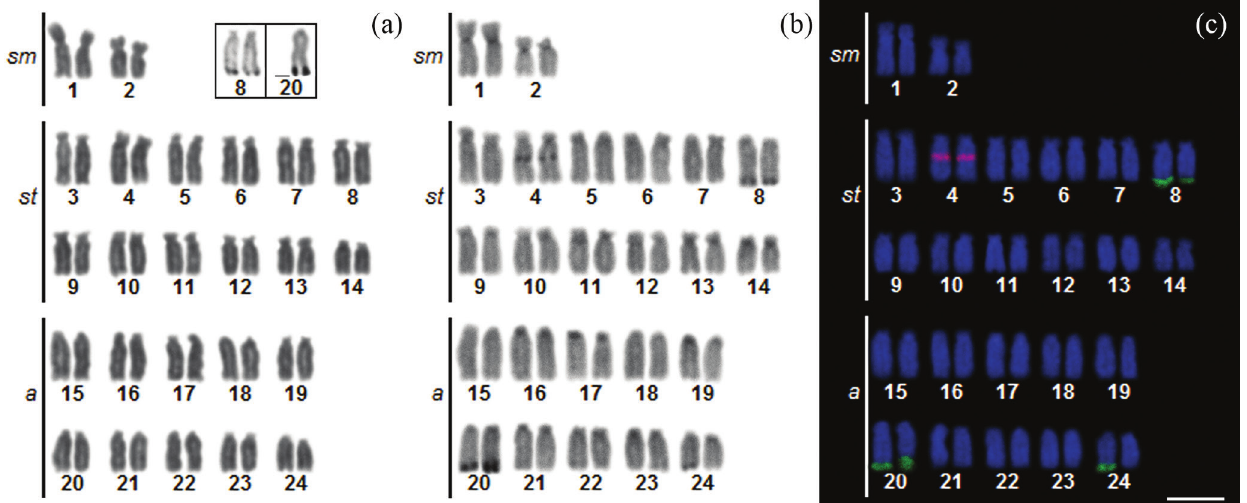
Fig. 2. Karyotypes of Gymnogeophagus setequedas : a. Giemsa stained; b. C-banded; and c. after fluorescence in situ hybridization with 5S rDNA probe (rhodamine, red) and 18S rDNA probe (FITC, green). NORs bearing chromosomes are boxed in Ag-stained (AgNORs). Scales bar = 5 µ